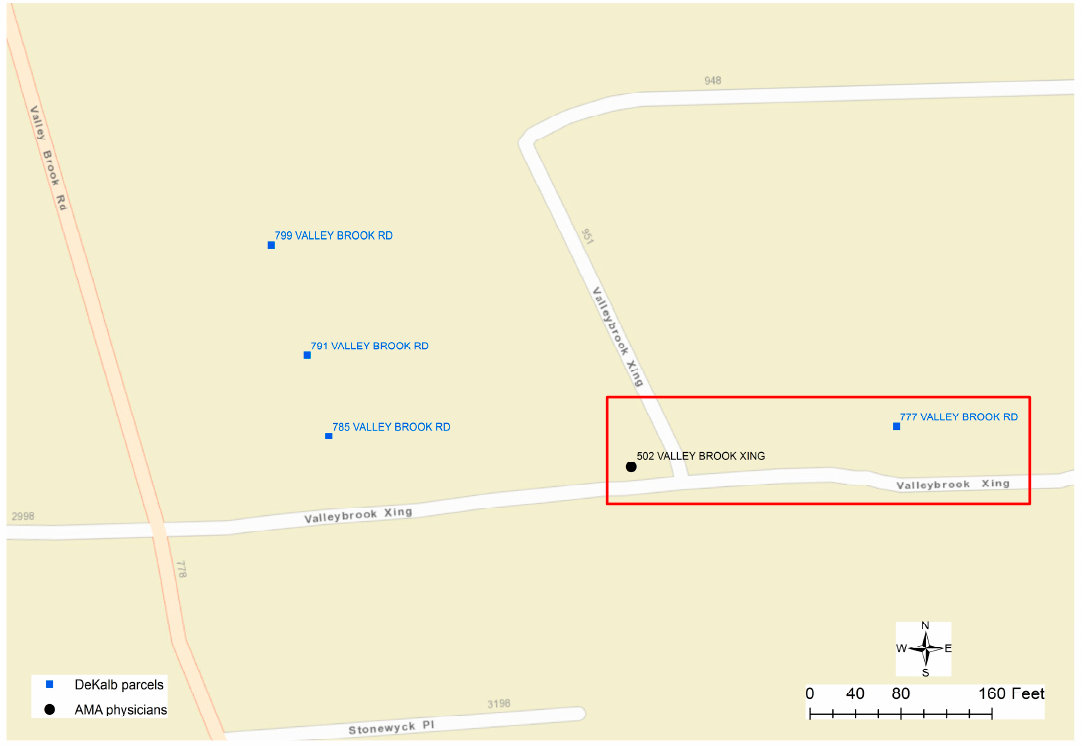
Figure 7. Misspelling error in parcel data.